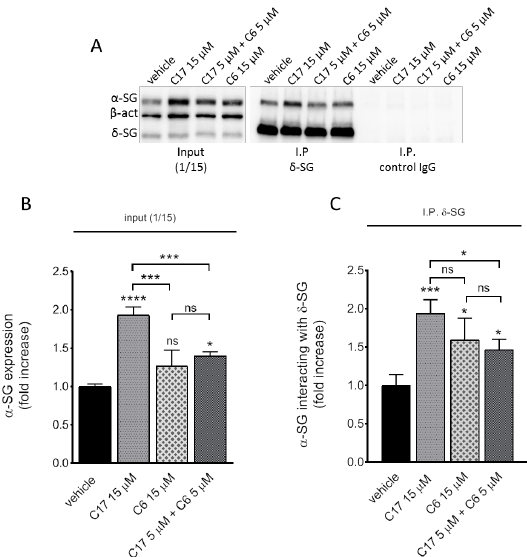
Figure 5. α-SG mutant rescued by correctors C6 and C17 forms a functional SG-complex. Myogenic cells from a patient carrying the L31P/V247M α-SG mutations were differentiated for 7 days and treated for